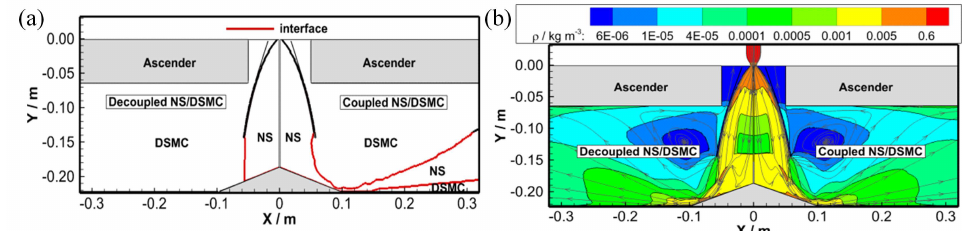
Figure 8. ( a ) Schematic of computation domain of decoupled and coupled methods. ( b ) The results of density obtained by the decoupled and coupled